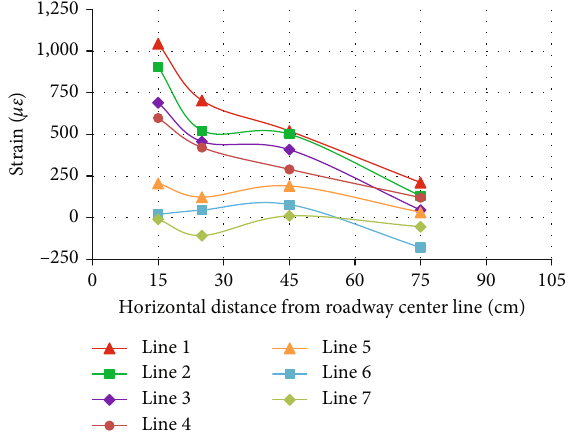
Figure 12: Curve chart of strain test results at di ff erent positions and measuring lines at the left side of the roadway center line (phase